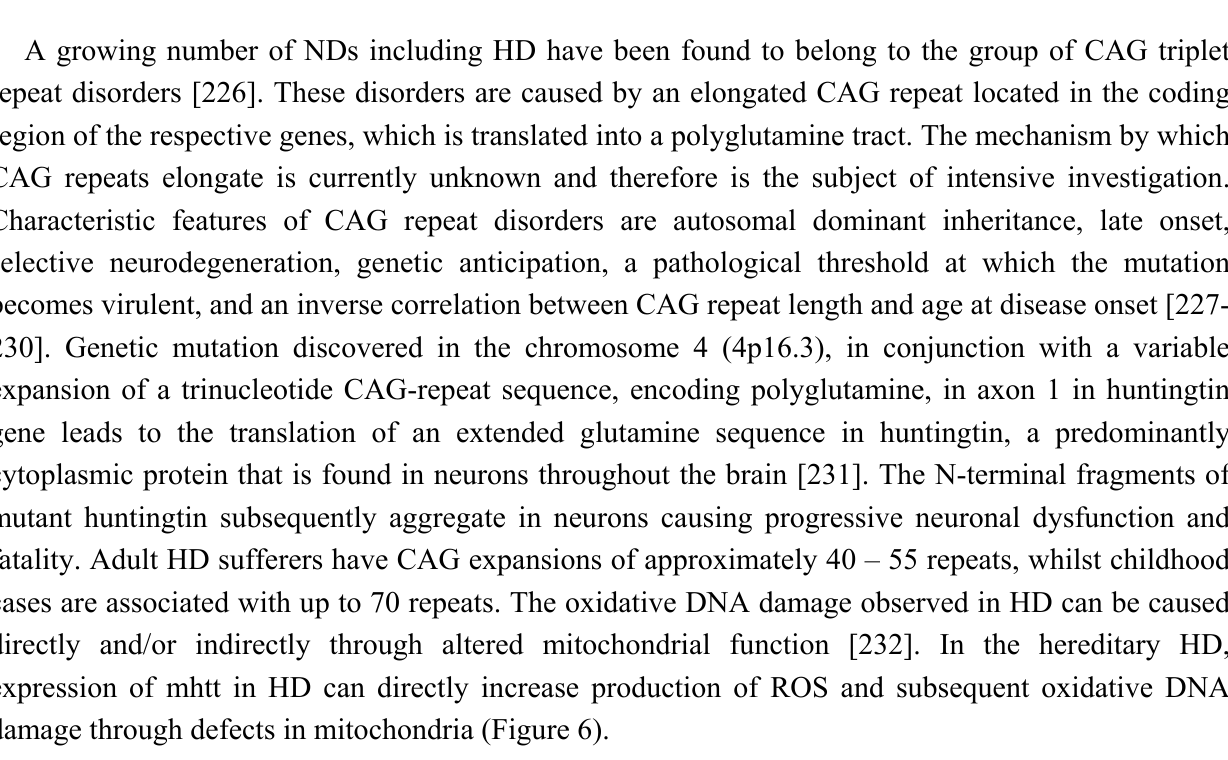
Figure 6. Schematic depicting a pathway of oxidative damage in HD (Source: Trushina and McMurray, [232]). Protein